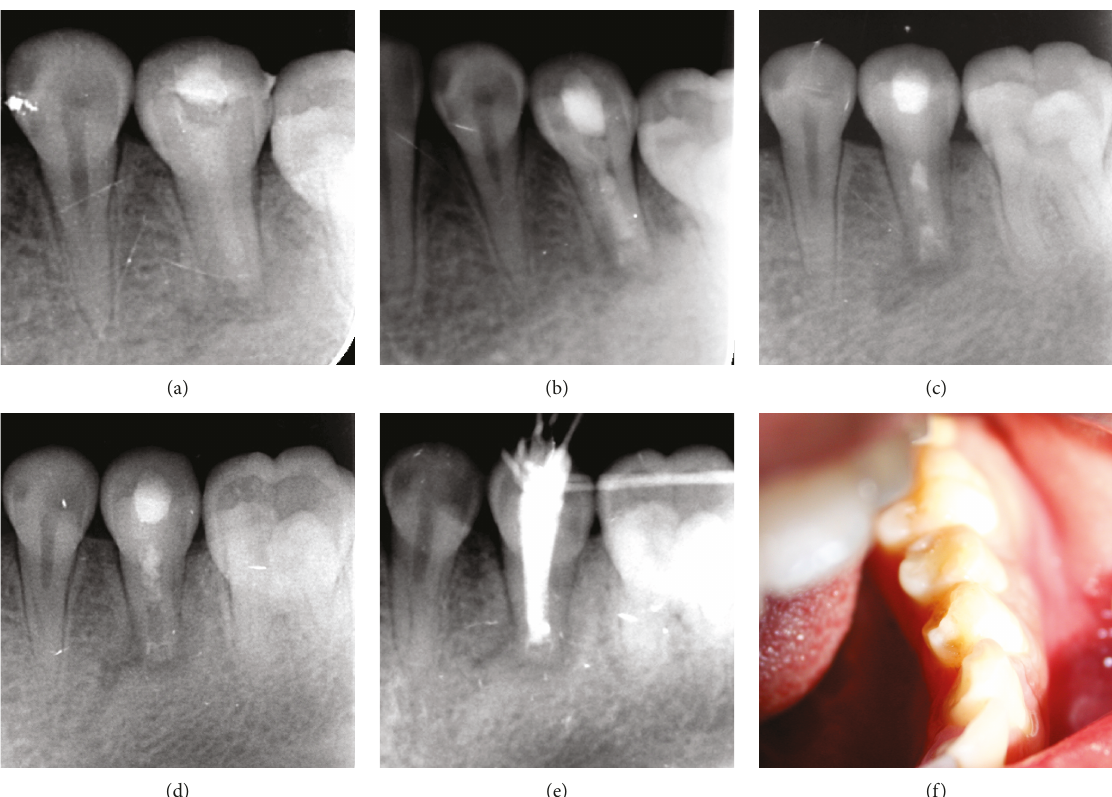
Figure 2: Follow-up periapical radiographs of this case. (a) The radiograph made directly after the initial treatment shows a compact fi lling of Ca(OH) paste with working length, an open apex, and a radiolucent lesion of tooth #20. (b) The radiograph made 3 months after the initial 2 paste in the canal and a slightly narrowed root apex. (c) The radiograph made after a new Ca(OH) treatment shows absorption of Ca(OH) 2 paste was placed. (d) 7 months after the initial treatment shows healing of the periapical bone, more reduction of the root canal space, and a signi fi cant root-end barrier. (e) The radiograph made after the root canal was fi lled with gutta-percha shows a signi fi cant root-end barrier and a compact fi lling. (f) The clinical photograph taken 2 years after the treatment was fi nished shows a sound tooth #20 without discoloration and disappearance of the patch in the buccal gingiva of tooth